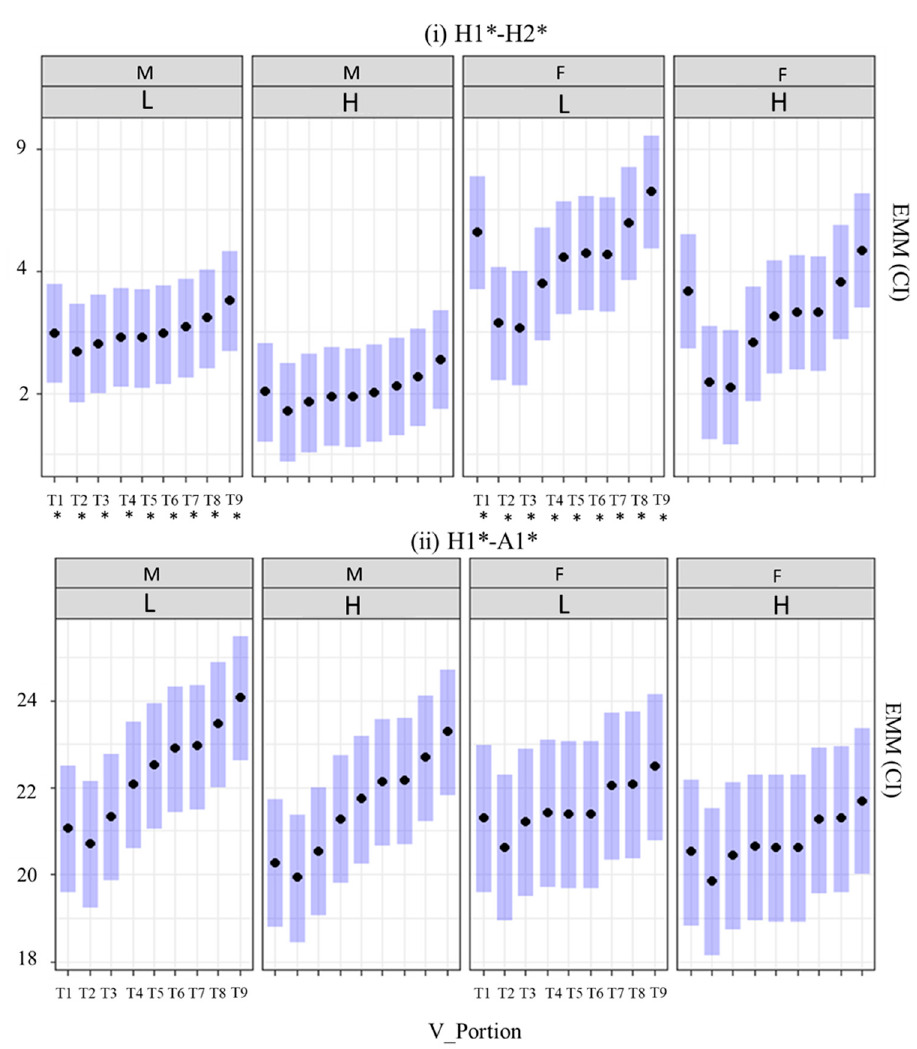
Figure 8. EMMs and confidence intervals (blue bars) of the nine timepoints of the vowels carrying contrastive tones (viz., low and high, indicated as L and H) derived from ( i ) H1*–H2* and ( ii ) H1*–A1* for male (M) and female (F) speakers. The asterisk (*) at each timepoint indicates the significance level of pairwise comparisons between the timepoint.